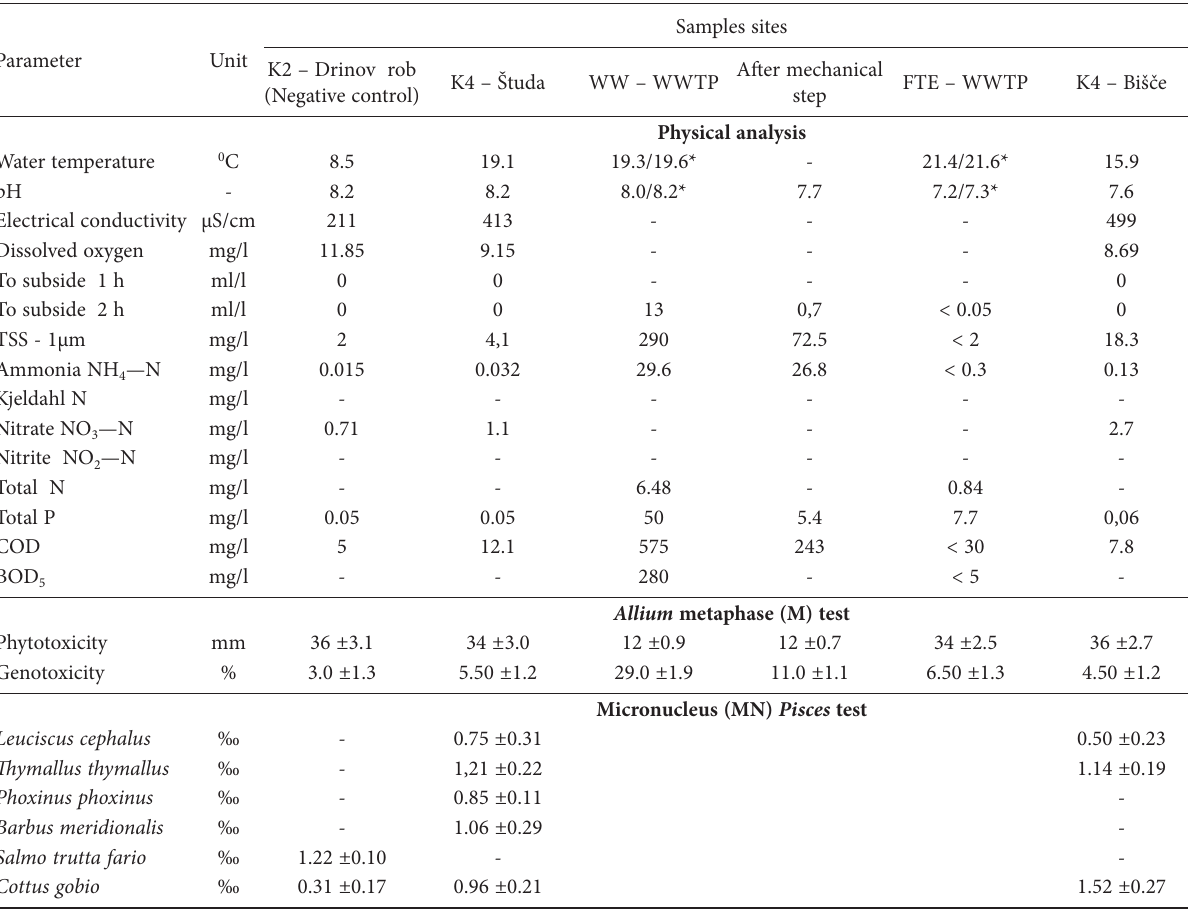
Table 5. United parameters physical quantities;cytological effects of the investigated samples survey – the genotoxicity level (damage to chromosomes) and general toxicity - phytotoxicity (root length inhibition) on the test onion plant A. cepa and Pisces micronuclei